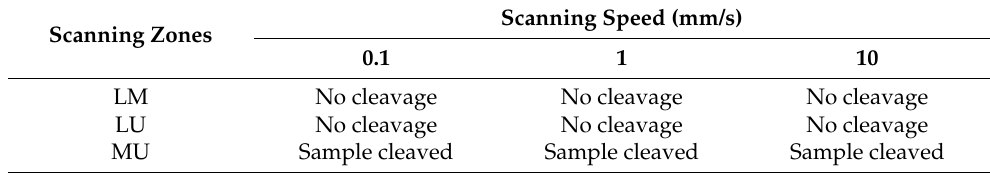
Table 2. Sample cleavage for various scanning zones and